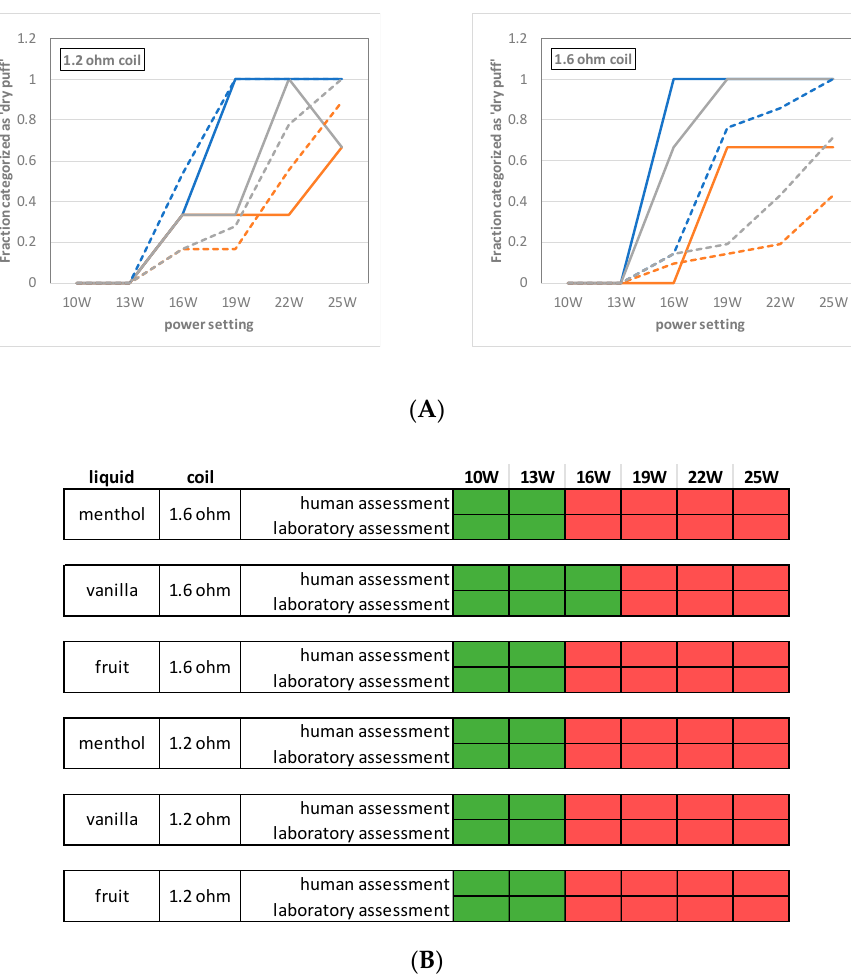
Figure 3. ( A ): Dry puff flavors of human assessment (dotted lines; these are the same data as shown in Figure 1) compared with the categorization based on laboratory analysis of dry puff markers (solid lines). Colors indicate flavor: menthol:blue, vanilla:orange, fruit:grey. At 25 W using the 1.2-ohm coil and the fruit-flavored e-liquid, one of the three laboratory measurements yielded unexpectedly low amounts of the dry hit markers, resulting in the unexpected “drop-off” of the graph from 22 W to 25 W. This was likely caused by a technical problem with the e-cigarette or vaping machine that occurred during this measurement, but the data were nevertheless retained because the reason is unknown. ( B ): Suitability of different power settings for each coil/liquid combination, as assessed by human e-cigarette users and based on the amounts of dry puff markers measured in the laboratory. For the “human assessment”, red indicates that 10% or more of the puffs for that liquid/coil/power setting combination were reported by the e-cigarette user panel to have dry puff flavor. For the “laboratory assessment”, red indicates that one or several dry puff markers exceeded its cutoff value (Table 1) for one or more of the three puffs analyzed.